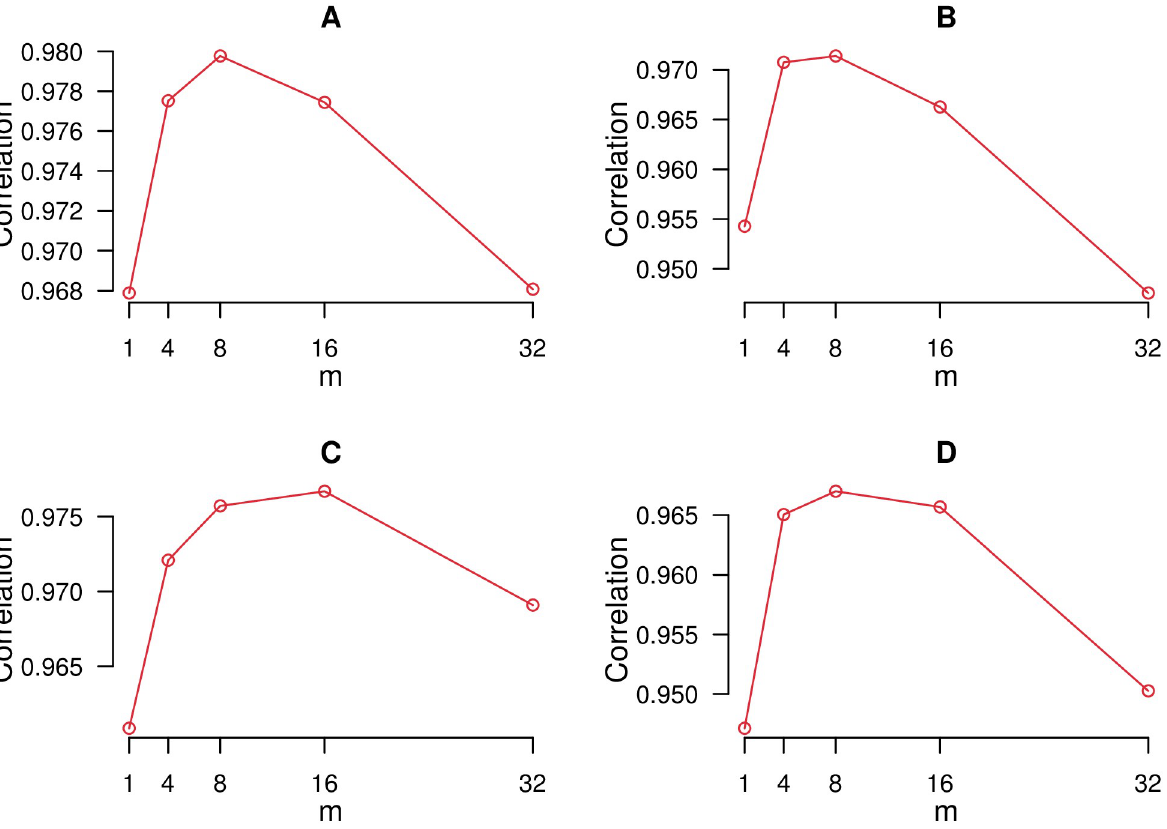
Fig 2. Correlation of prediction on training data against the number of nearby census tracts used to perform prediction ( m ). A: Search query based model for asthma. B: Search query based model for COPD. C: Land cover model for asthma. D: Land cover model for COPD.